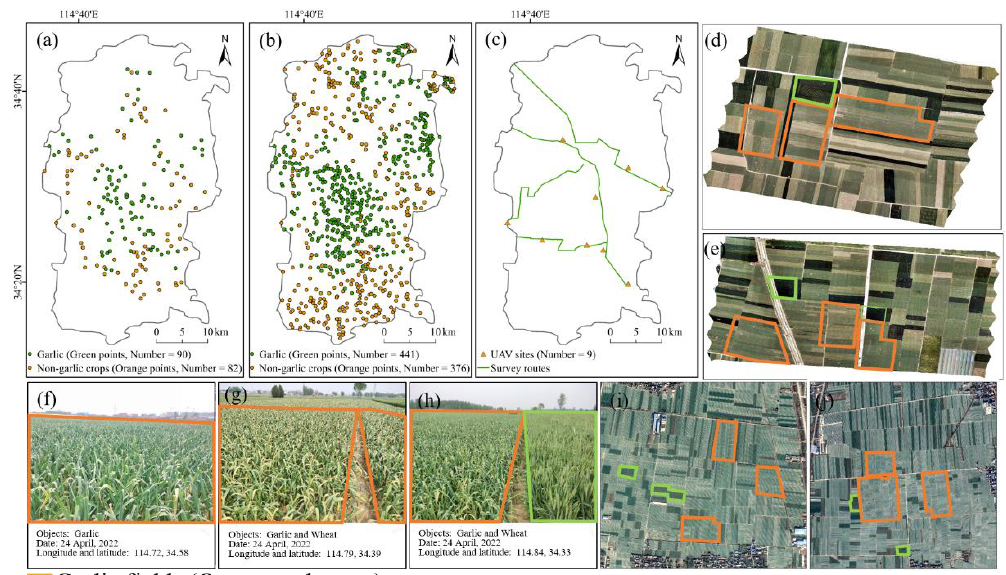
Figure 2. ( a ) Distribution of training samples for garlic and non-garlic crops. ( b ) Distribution of validation samples, including polygons of garlic and non-garlic crops. ( c ) Distribution of UAV sites and survey routes. ( d , e ) UAV images. ( f – h ) Ground observations from field camera. ( i , j ) Very-high- spatial-resolution images from Google Earth.